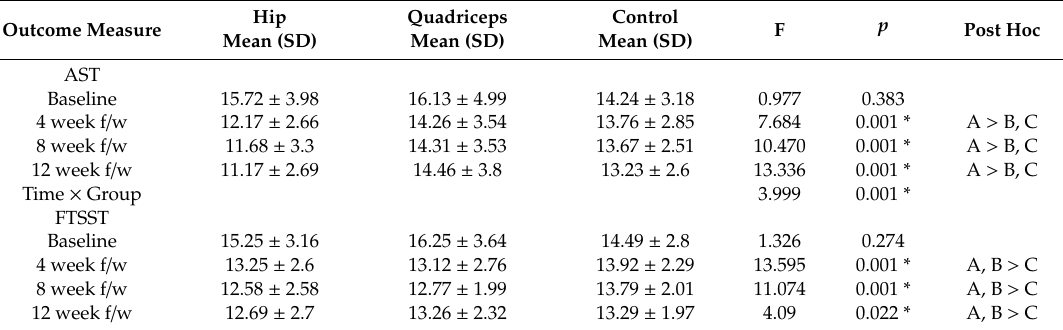
Table 5. Outcome scores for each group at baseline (week 0), post-intervention (week 4), follow-up (week 8), and follow-up 2 (week 12): mean and standard